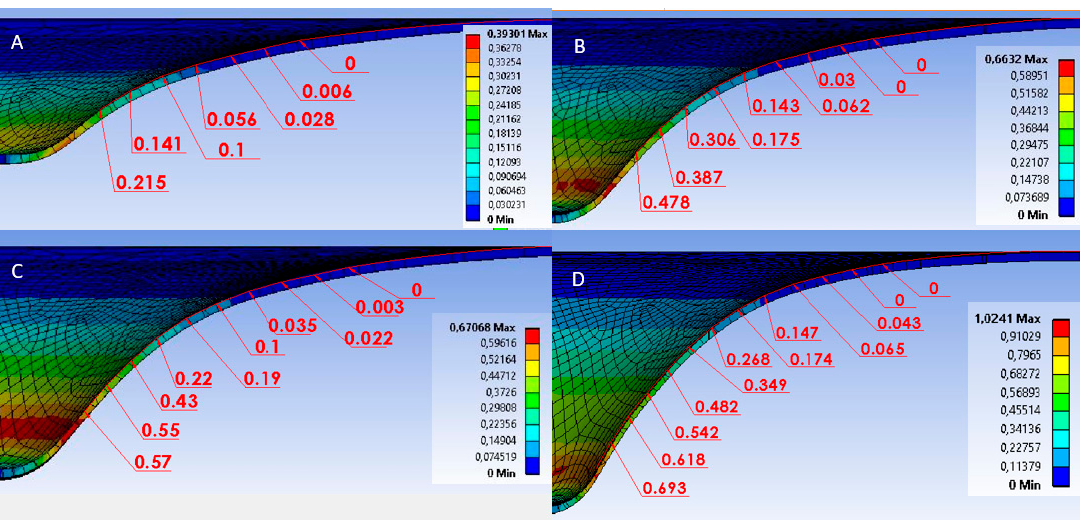
Figure 8. Thickness obtained by FEM and experimentally. ( A ) Room temperature. ( B ) 200 °C. ( C ) 300 °C. ( D ) 400 °C.